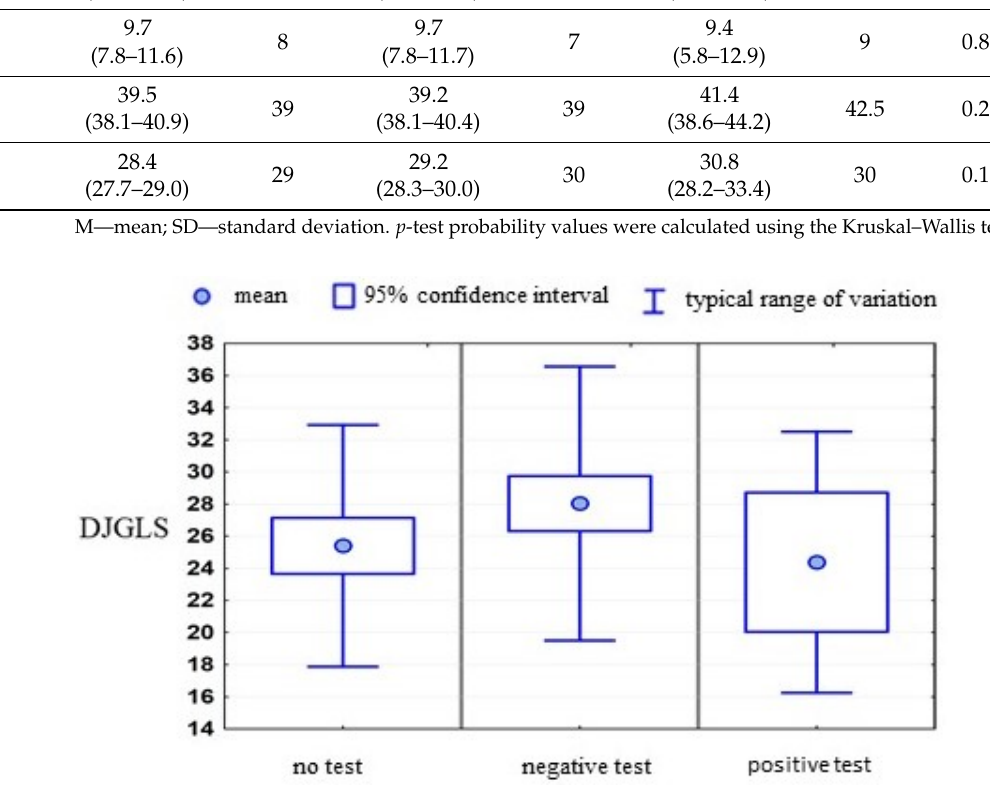
Figure 3. Correlations between the applied psychometric scales and the result of the COVID-19 test. Mean value +/ − standard devaition.